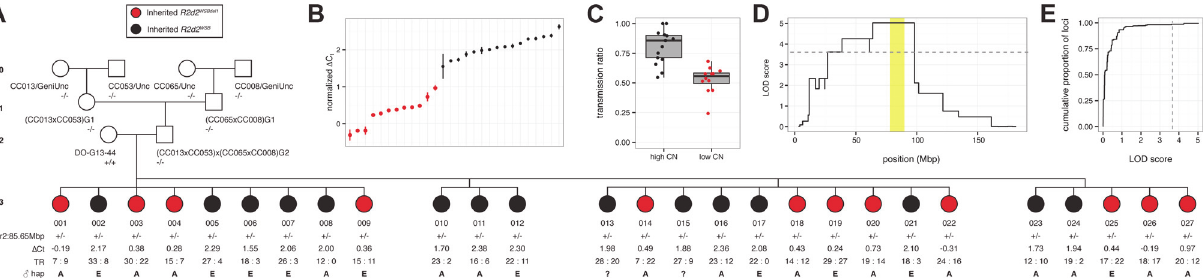
Figure 4. Mapping the causal locus for maternal TRD in a family segregating for a copy-number variant at R2d2 . A) Pedigree of DO-G13 – 44xCC cross. Female DO-G13 – 44, mother of the G3 dams phenotyped for TR, is segregating for a copy-number variant at R2d2 . G3 dams inheriting the maternal WSB/EiJ haplotype associated with the high-copy allele ( R2d2 WSB ) are colored black; those inheriting the WSB/EiJ haplotype associated with the low-copy allele ( R2d2 WSBdel1 ) are colored red. Genotypes at marker chr2:85.65Mbp is denoted -/- (homozygous non-WSB), +/- (heterozygous WSB/EiJ) or +/+ (homozygous WSB/EiJ). Δ C t , normalized cycle threshold by TaqMan qPCR assay; TR, transmission ratio, denoted as count of progeny inheriting a WSB/EiJ allele: count of progeny not inheriting a WSB allele; the paternal haplotype at chr2:83.6 Mb as determined by genotypes from the MegaMUGA array using the standard CC abbreviations is shown, A = A/J, E = NZO/HILtJ, ? = haplotype unknown. B) Distribution of Δ C t values among 27 G3 dams. Points are colored as in panel A. C) TR among 27 G3 dams partitioned according to copy-number (CN) haplotype at R2d2 . Points are colored as in panel A. D) QTL scan for TRD, treated as a binary phenotype, in 25 G3 dams genotyped with MegaMUGA. Only the maternal signal from Chr 2 is shown. Grey dashed line indicates threshold for significance at α = 0.01 obtained by unrestricted permutation. Candidate interval for R2d is shaded yellow. E) Empirical cumulative distribution of both maternal and paternal LOD scores genome-wide, with α = 0.01 significance threshold indicated by grey dashed line.